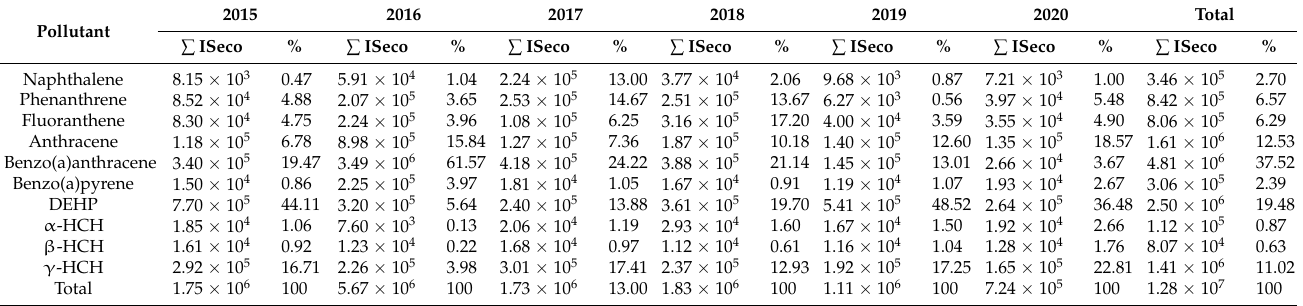
Table 7. Total impact scores obtained in the period 2015–2020 and the contribution of heavy metals.